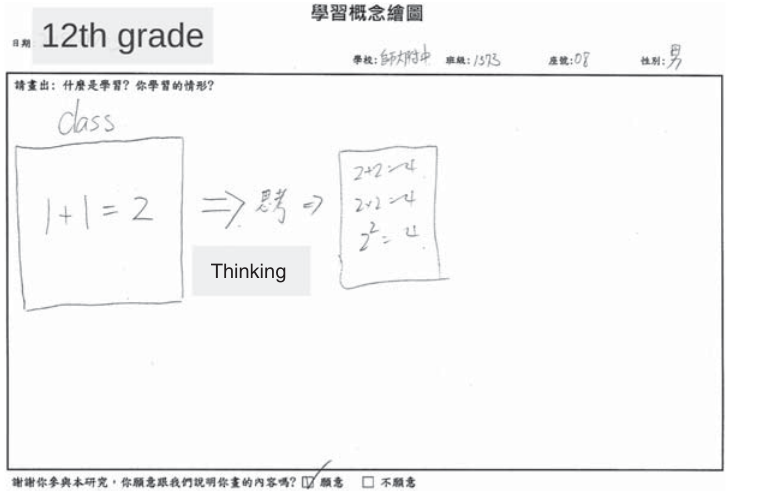
Figure 5. A drawing by a 12th grade student showing